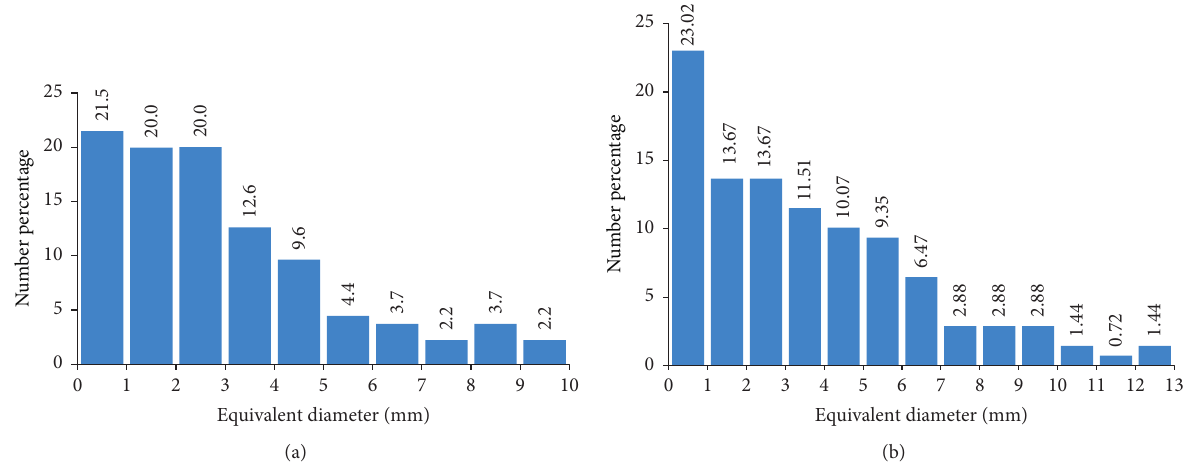
Figure 9: The number of pores with different equivalent diameter: (a) specimen 1#; (b) specimen